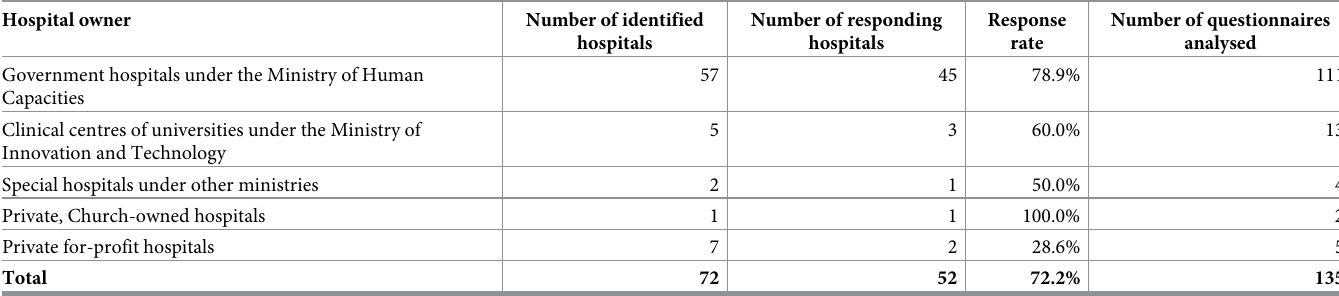
Table 2. Description of the sample of institutions and response rates by